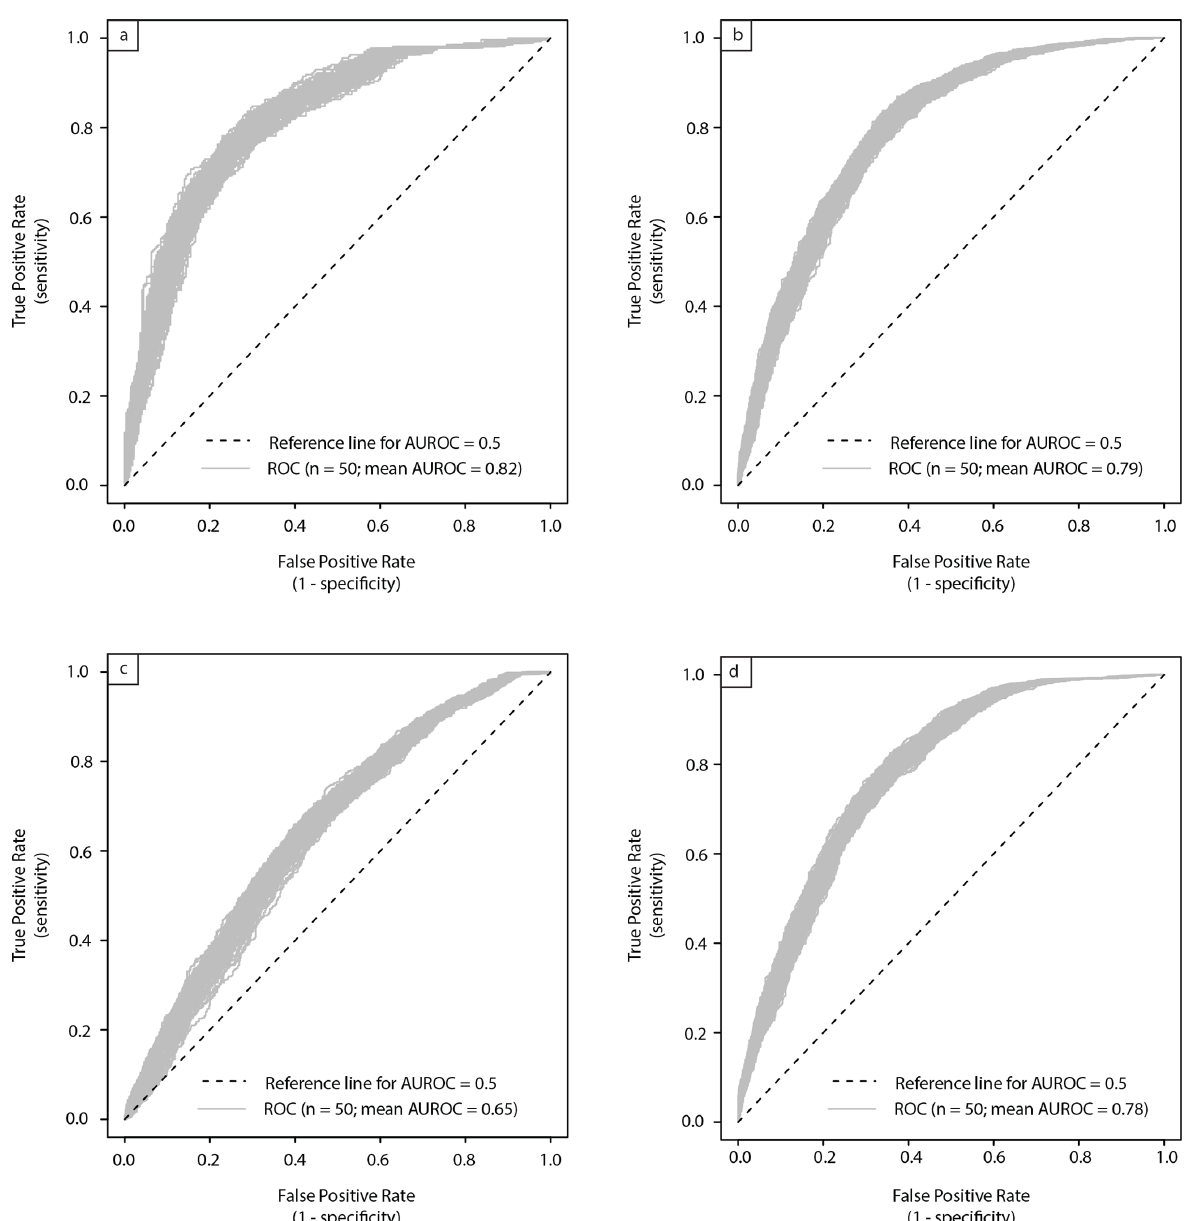
Figure 5. Receiver operator curves (ROCs) showing the success of (a) the 2018 model classifying the independent 2018 testing data, (b) the 2009 model classifying the independent 2009 testing data, (c) the 2019 model classifying the independent 2019 testing data, and (d) the 2018 + 2009 model classifying the independent 2018 + 2009 testing data. In each case the reference ROC for a “random” model with 50% accuracy is shown, as is the mean area under the receiver operator curve (AUROC) value for all